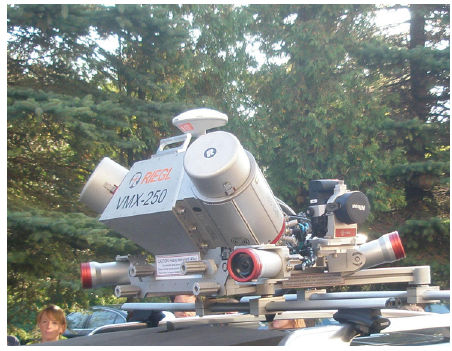
Figure 4. System II based on a Riegl solution (VMX 250).